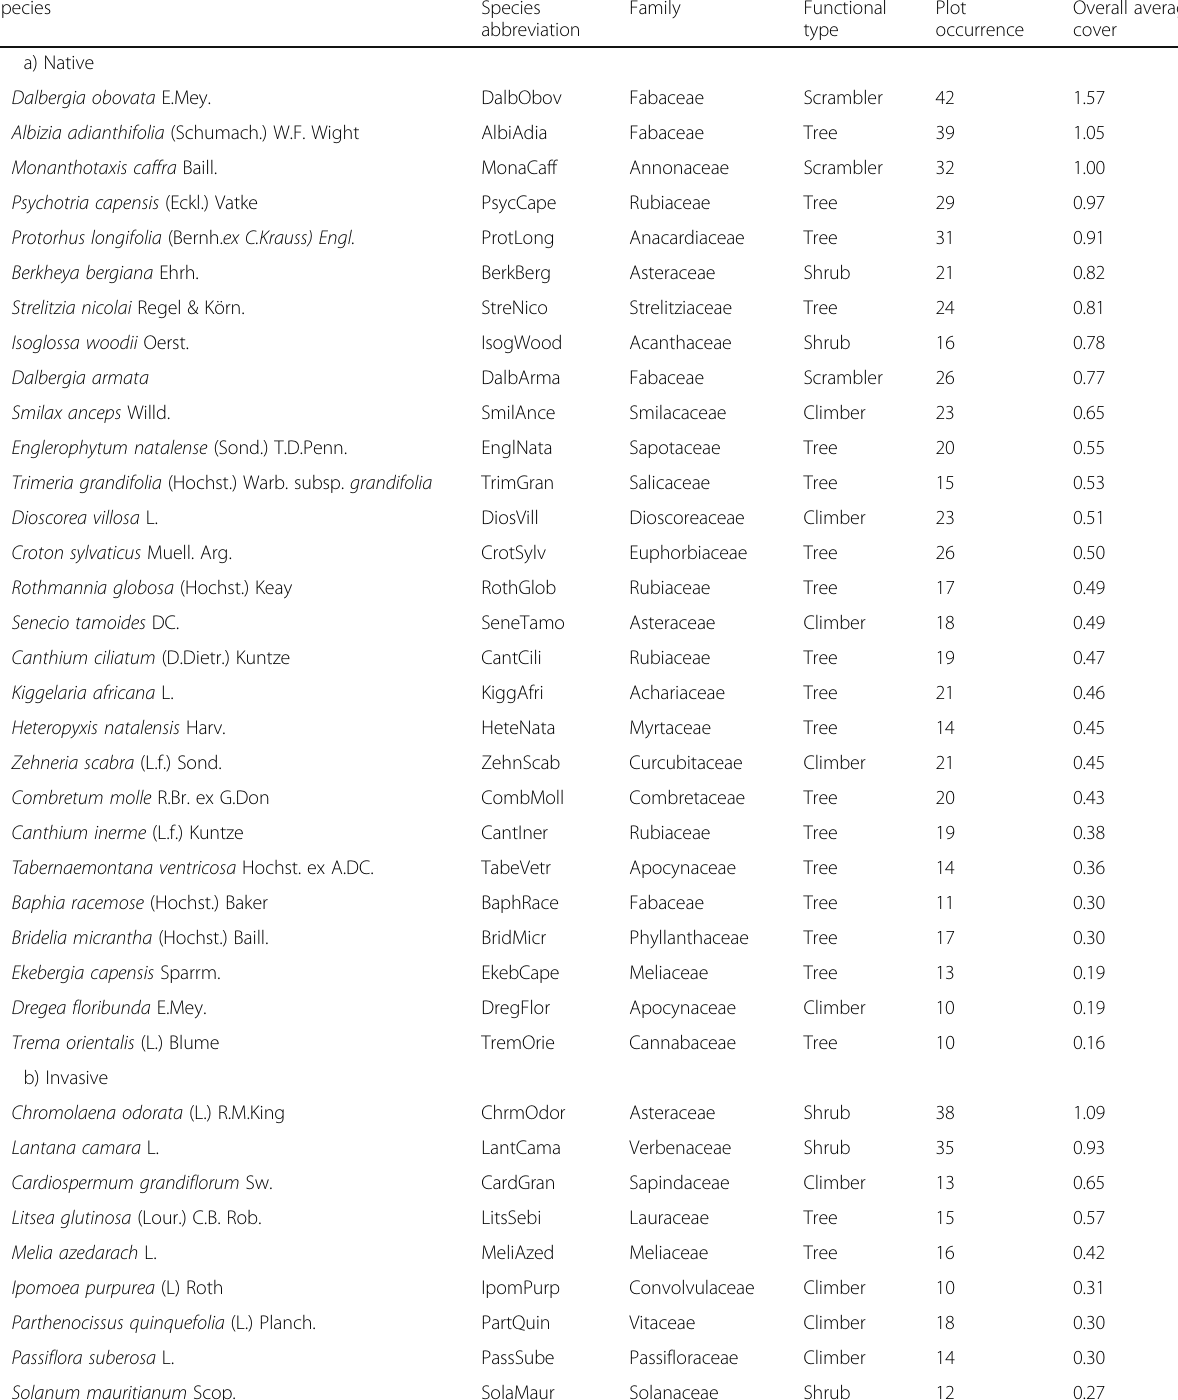
Table 3 The important native and invasive species retained for analysis determined by average rank of cover of DAFOR scale for all